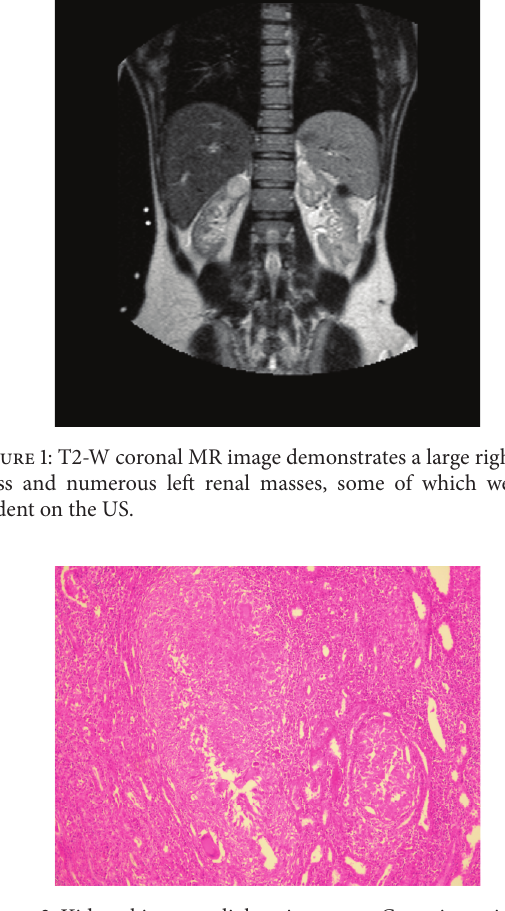
Figure 2: Kidney biopsy on light microscopy. Caseating epithelioid cells with granulomas and Langhans giant cells on renal tuberculo- sis. Hematoxylin-eosin stain, original magnification ×